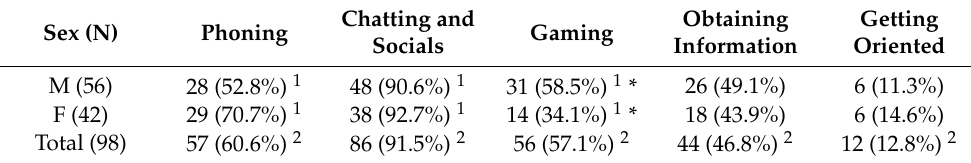
Table 2. Prevalent use of mobile phones among participants.